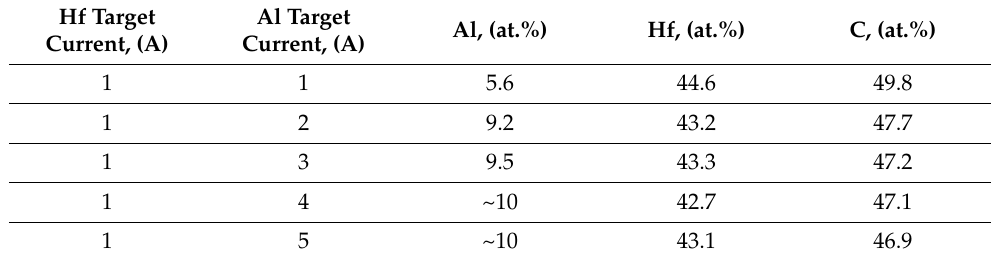
Table 1. Elemental composition of Hf–Al–C films in dependence on the deposition conditions. Hf